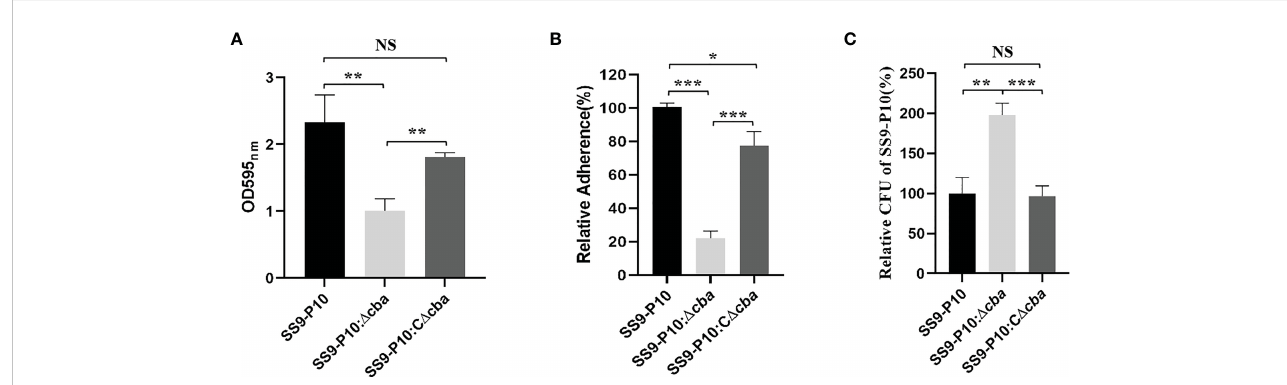
FIGURE 3 Virulence assessment in vitro . (A) Bio fi lm biomass was expressed as crystal violet optical density (OD540nm). (B) The adherence rate of SS9-P10 is signi fi cantly higher than SS9-P10 D cba . (C) A total of 5.0×10 5 Raw264.7 cells were infected separately with the SS9-P10: D cba , SS9-P10:C D cba or SS9-P10 at an MOI of 10:1 for 1 (h) CFUs of phagocytosed bacteria recovered from macrophages were examined. SS9-P10: D cba were more susceptible to phagocytosis, whereas SS9-P10:C D cba recovered the phenotype to the level of SS9-P10. Data are expressed as the mean ± SEM of three independent